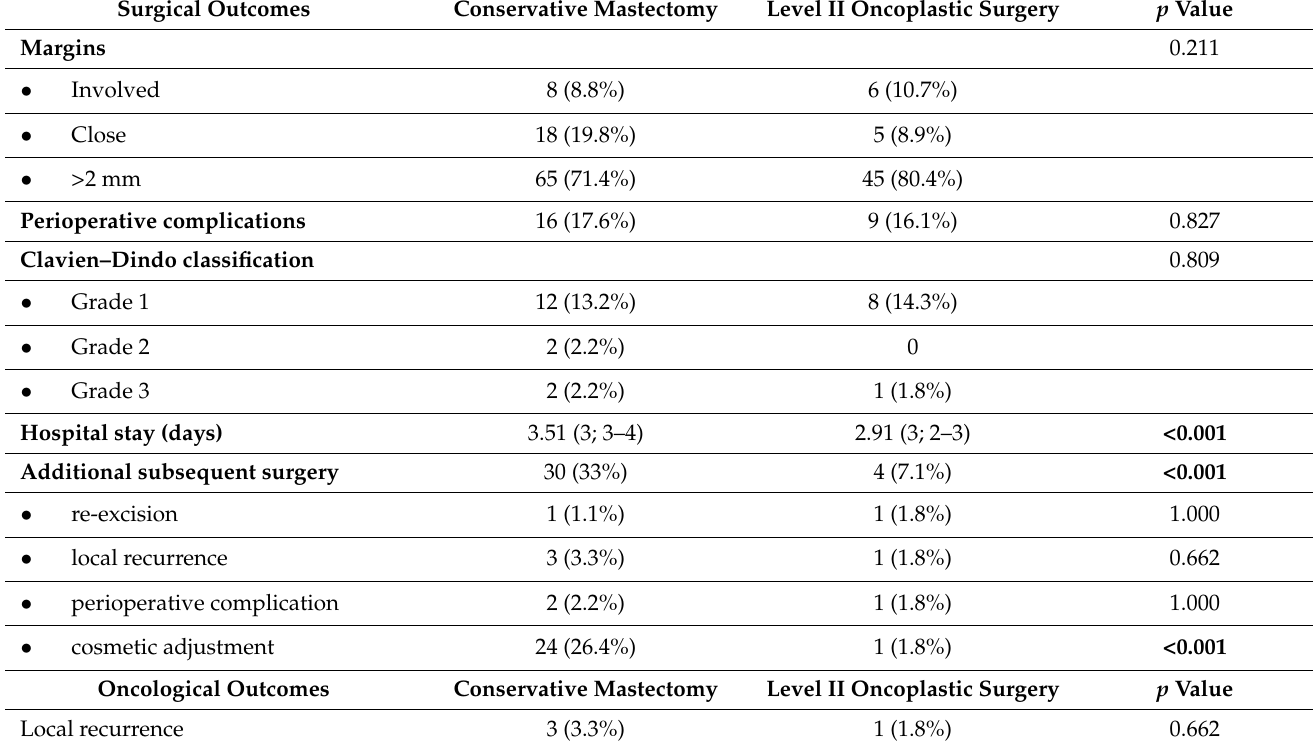
Table 4. Surgical and Oncological